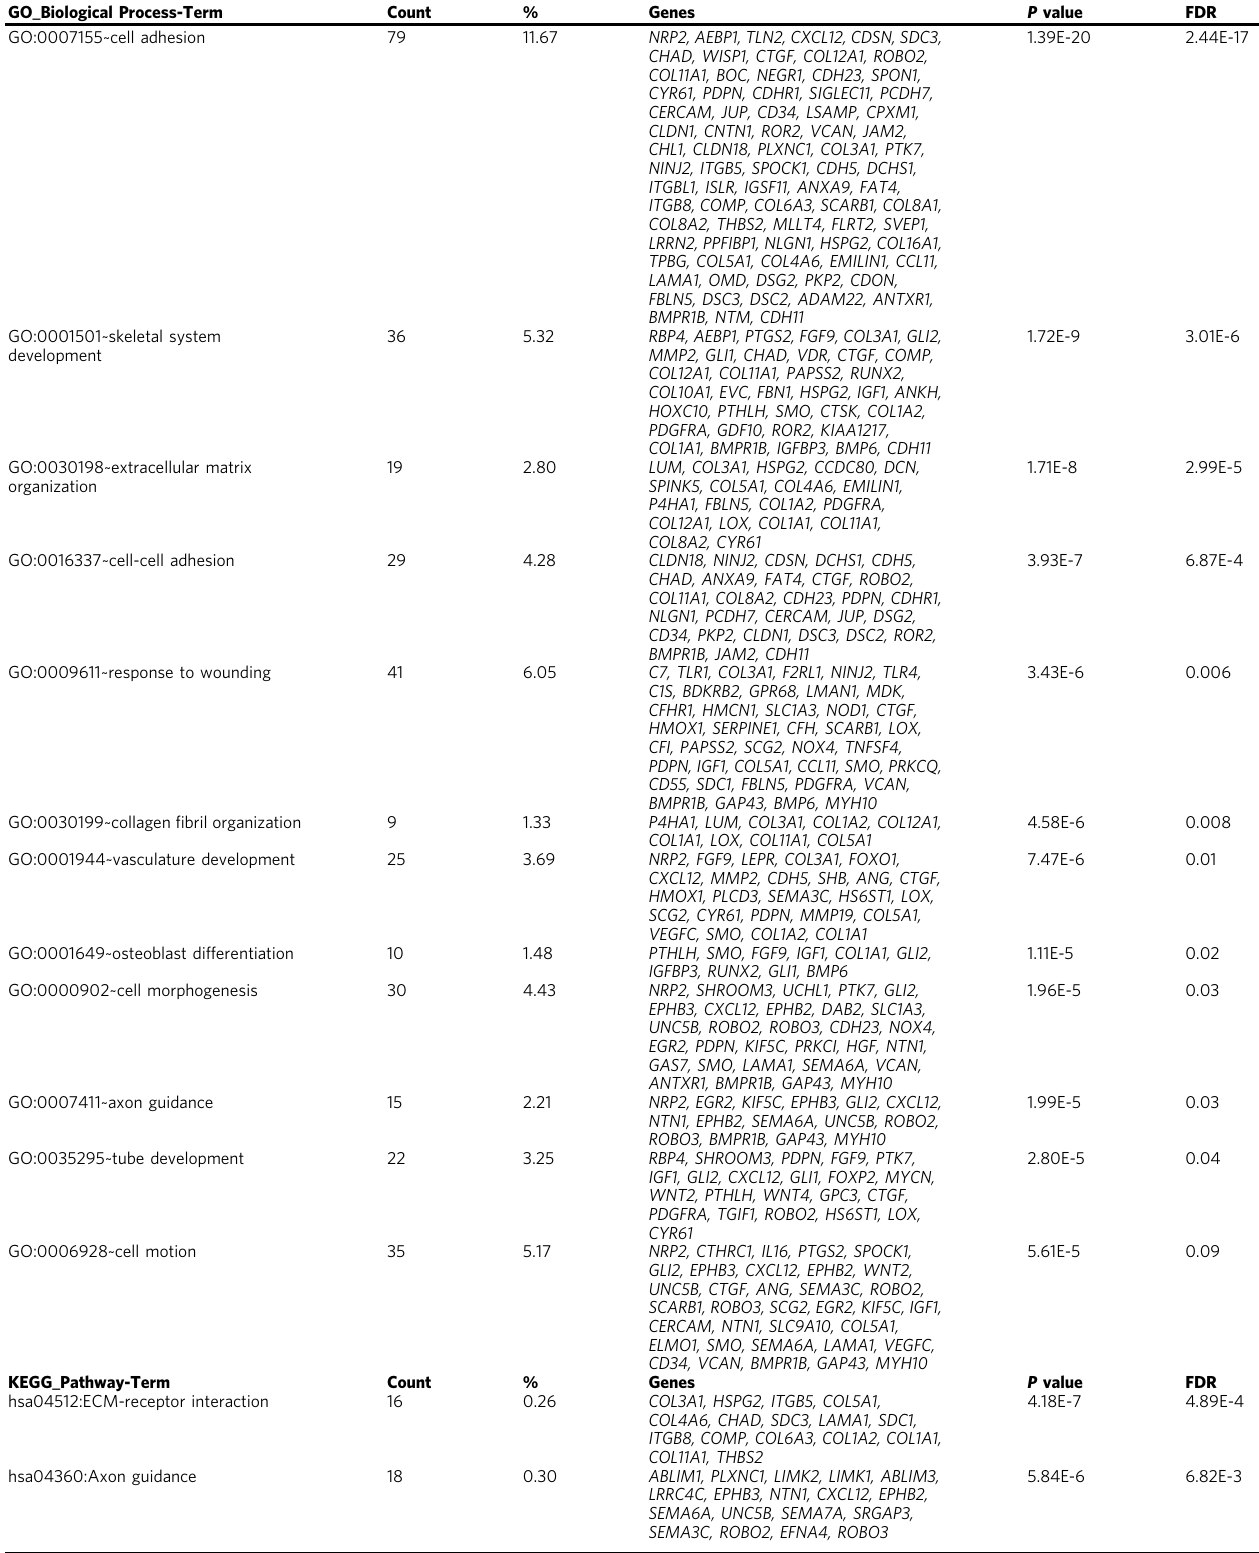
Table 2 Signi fi cant enriched pathways for genes upregulated in CAF-S1 versus